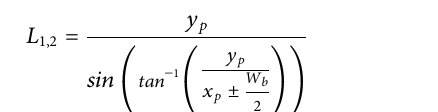
FIGURE 2 | System drawing of the bimanual robot for rehabilitation BiCAR that applies a patient-cooperative shared control strategy. Adapted from standard IEC 80601-2-78:2019 (IEC, IEC,